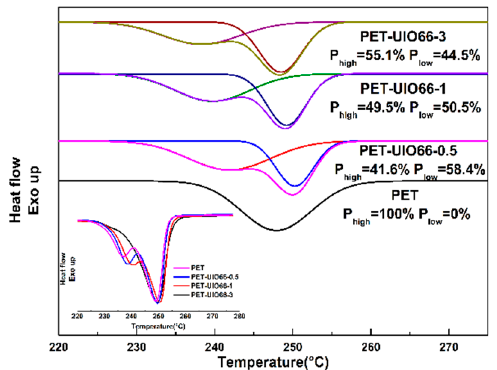
Figure 12. The original melting curve and the second heating process fitting curve of the PET and the PET/UIO-66 nanocomposites.